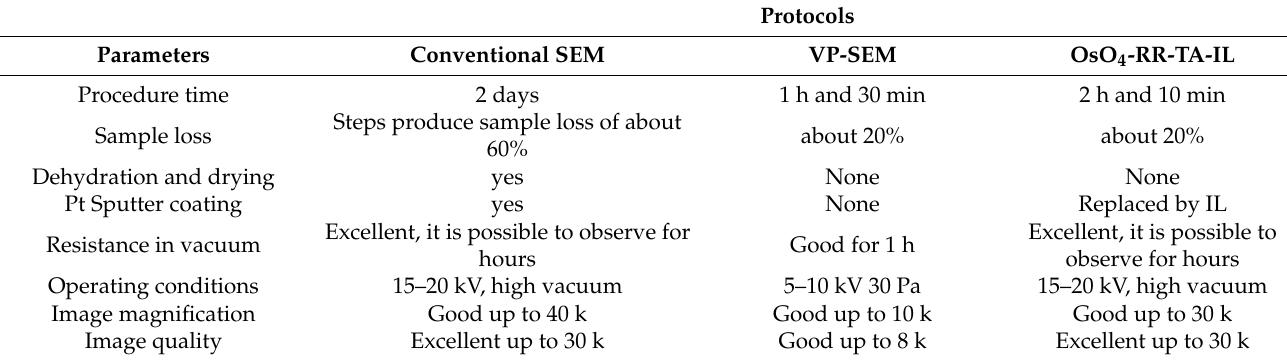
Table 3. Parameters for the protocol evaluation (from